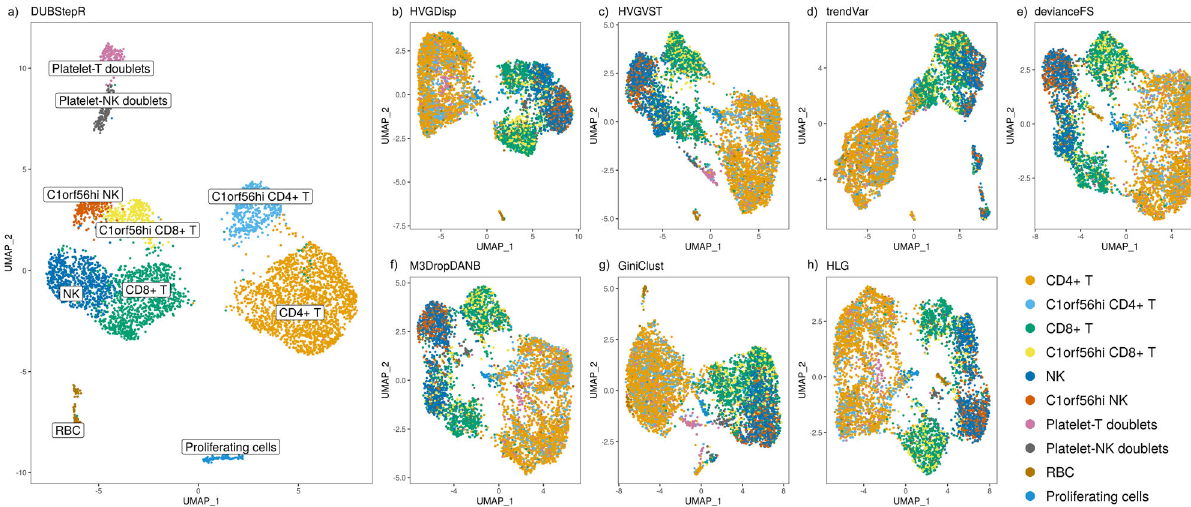
Fig. 6 Analysis of lymphocyte population from rheumatoid arthritis patient PBMCs. a UMAP visualization of clusters identi fi ed by DUBStepR. b – h UMAP visualization of cell clusters identi fi ed by DUBStepR using features selected by the 7 other feature selection methods; b HVGDisp, c HVGVST, d trendVar, e devianceFS, f M3DropDANB, g GiniClust, and h